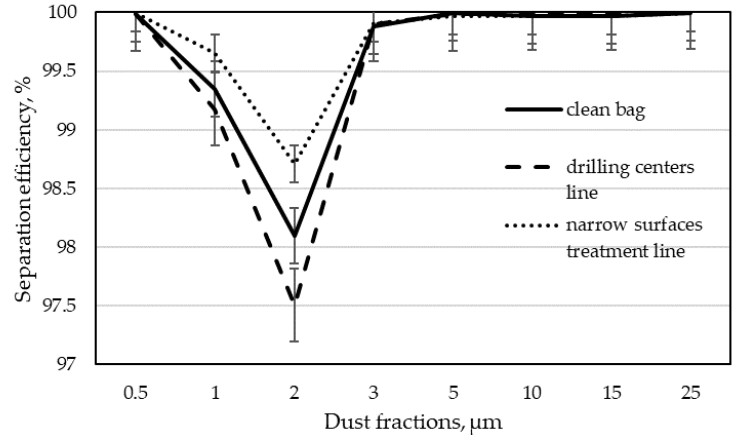
Figure 5. Fractional separation efficiency for 133 days of operation time of filter bags in individual dust extraction installations.